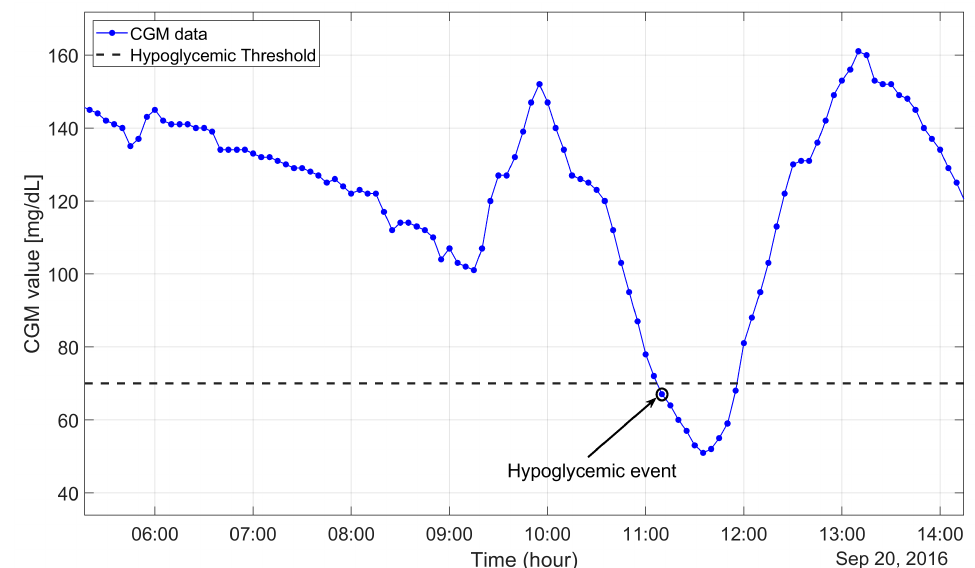
Figure 2. Example of real continuous glucose monitoring (CGM) data of hypoglycemic event onset. Hypoglycemia Prediction